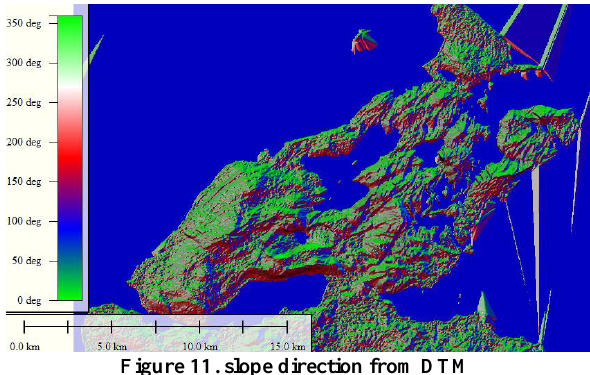
Figure 11. slope direction from DTM 3.3. Height difference test and longitudinal profile Height difference test is done by making closed polygons.